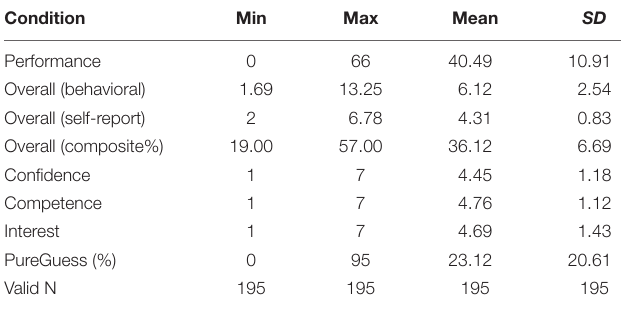
TABLE 1 | Descriptive statistics for control and outcome variables.